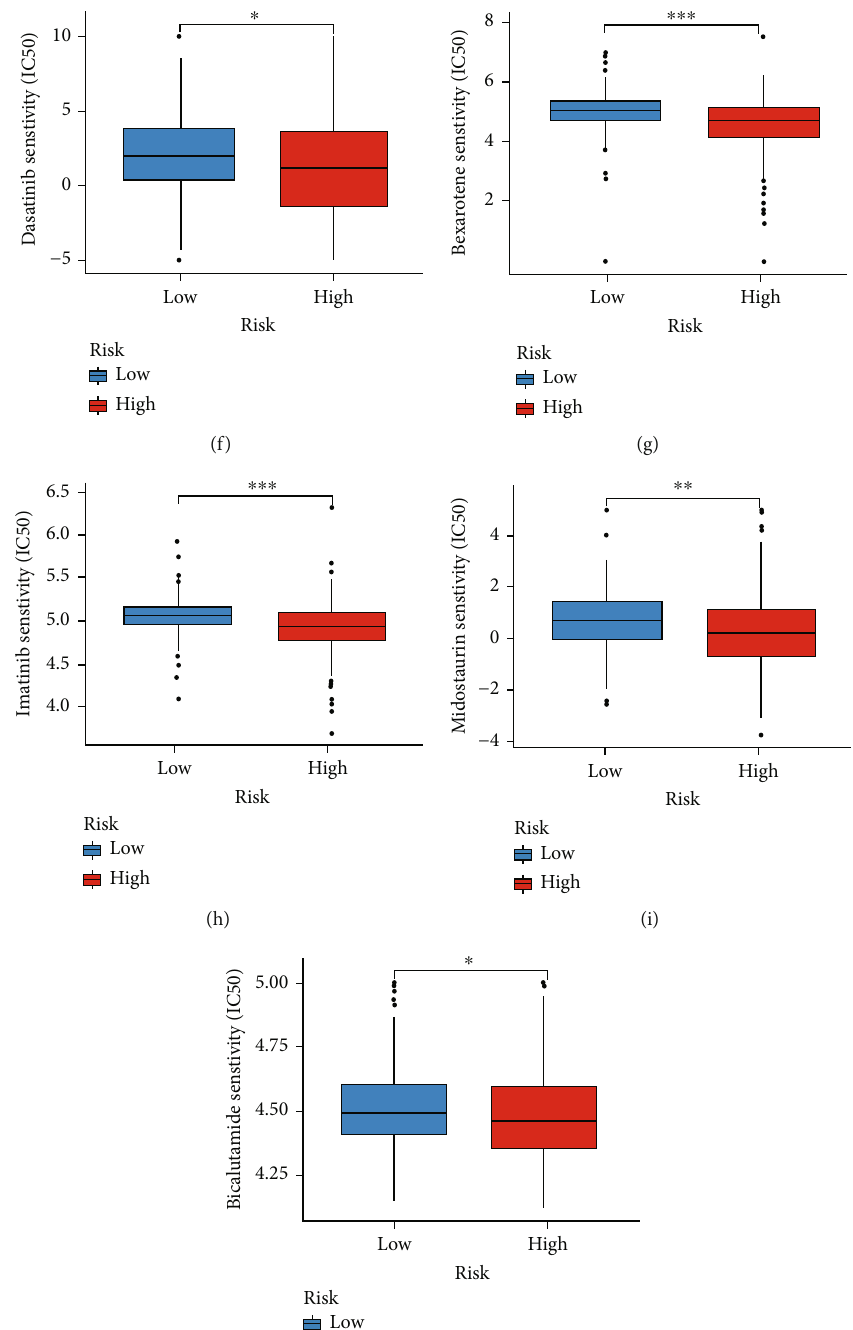
Figure 10: Candidate vaccine genes and therapeutic drugs for gastric cancer. (a) Distribution of genes with copy number variation in gastric cancer. (b) The distribution of di ff erent genes on chromosomes between gastric cancer and normal tissues, where red is the upregulated gene in gastric cancer and green is the downregulated gene. (c) The survival curve of PTPN6 in gastric cancer. (d) The correlation analysis between PTPN6 and tumor purity, antigen-presenting cells, and B cells. (e – j) The IC50 value of di ff erent chemotherapy drugs in the high- and low-risk groups in TCGA dataset ( ∗ P < 0 : 05 , ∗∗ P < 0 : 01 , ∗∗∗ P < 0 : 001